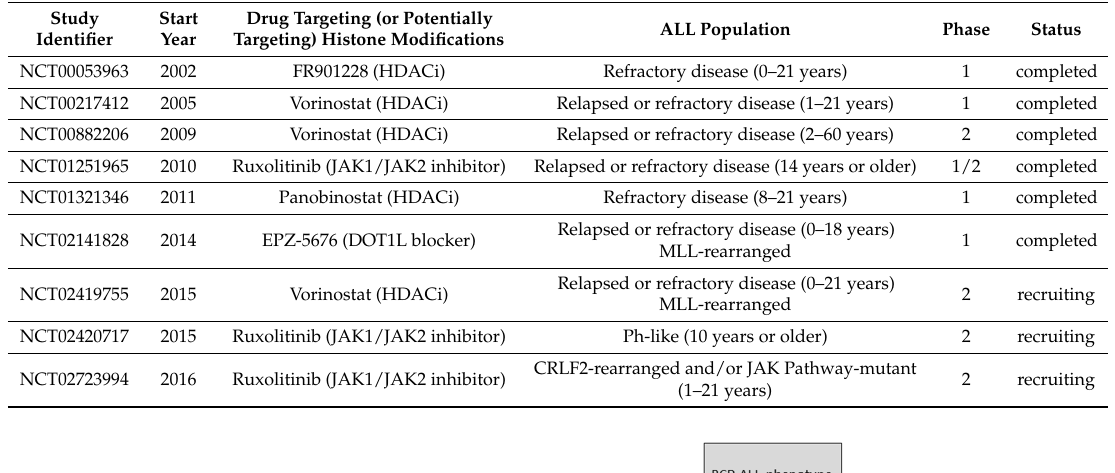
Table 2. Active and completed clinical trials of drugs potentially targeting histone mark writers and erasers in pediatric BCP-ALL (as accessed on 25 October 2016, at www.clinicaltrails.gov).